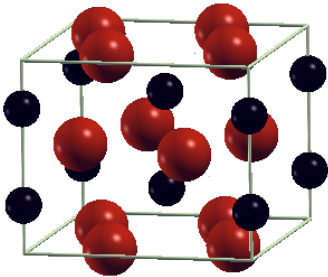
Figure 1. The tetragonal Cu 2 Al structure type ( I4/mcm space group) of the Fe 2 B alloy, with Fe atoms (red spheres) and B atoms (black spheres).